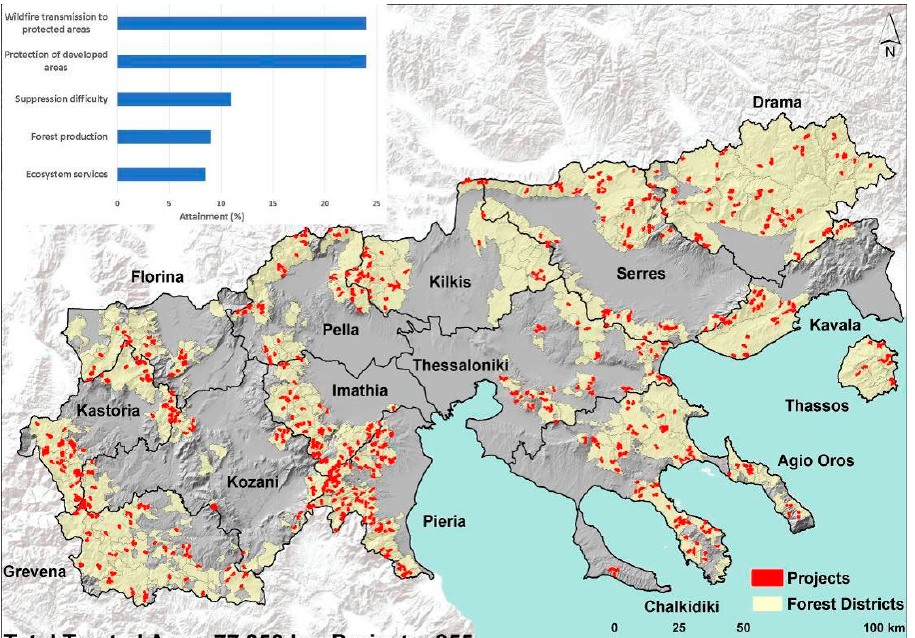
Figure 6. The best 100-hectare projects for each priority with a four-year fuel treatment plan with an annual treatment pace, combined to remove repeated inclusion of the same stands selected by two or more priorities. In total, 855 projects resulted in 77,350 ha of treated area. Attainment for each priority, if all stands that appear on the map are treated, is shown at the upper left corner.